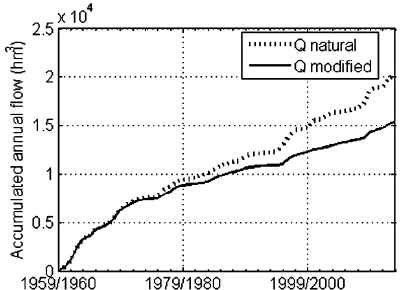
Figure 4. Annual natural regime flow (restored) and annual mod- ified regime flow (measured discharges) (hydrological year from September to August) accumulated throughout the study period in the final stretch of the Guadalete River, downstream the confluence of the two main rivers.